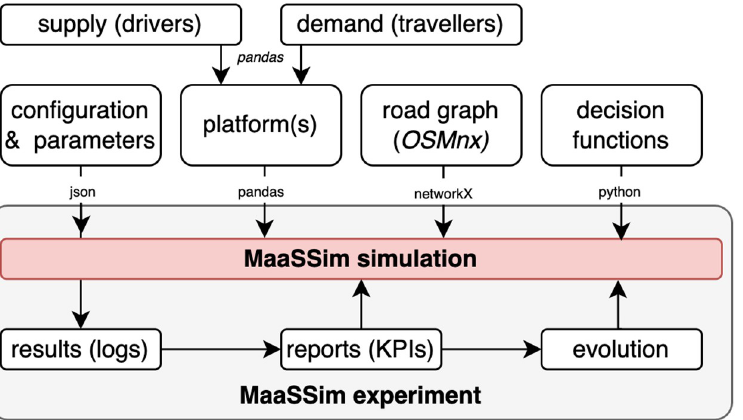
Fig 2. Input and output of MaaSSim